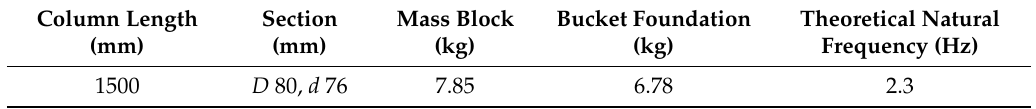
Table 1. Properties of the primary structure.